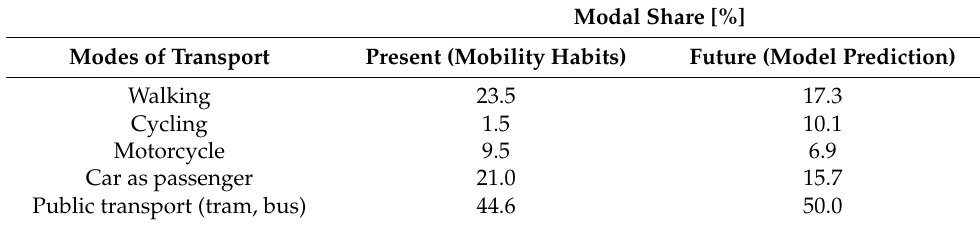
Table 5. Modal shares for the five modes of transport in the present and in the